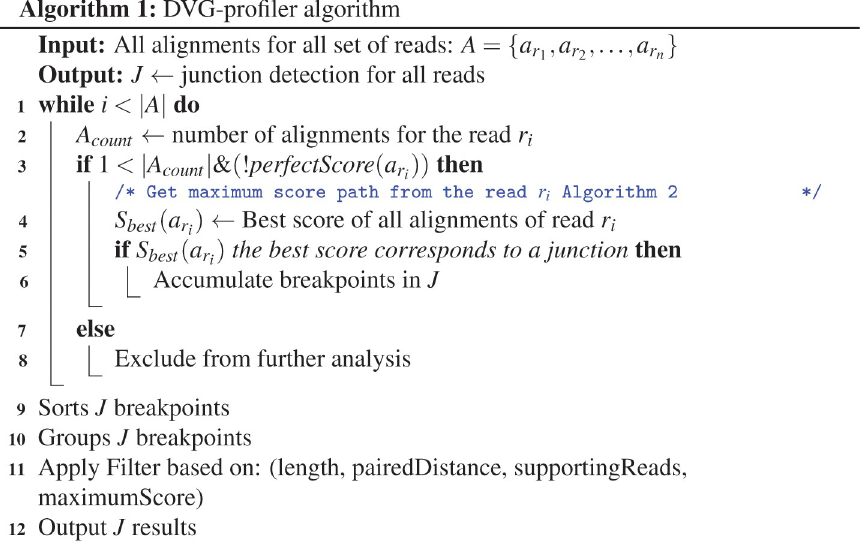
Fig 3. Algorithm 1 pseudocode of DVG-profiler. The input of the algorithm is a set of alignments sorted by reads, so alignments from the same read appear consecutively. Each subset of alignments derived from the same read is examined for all the combinations to find the best pair. Pairs reporting breakpoints are sorted, grouped and filtered before being presented. See materials and methods for further information.